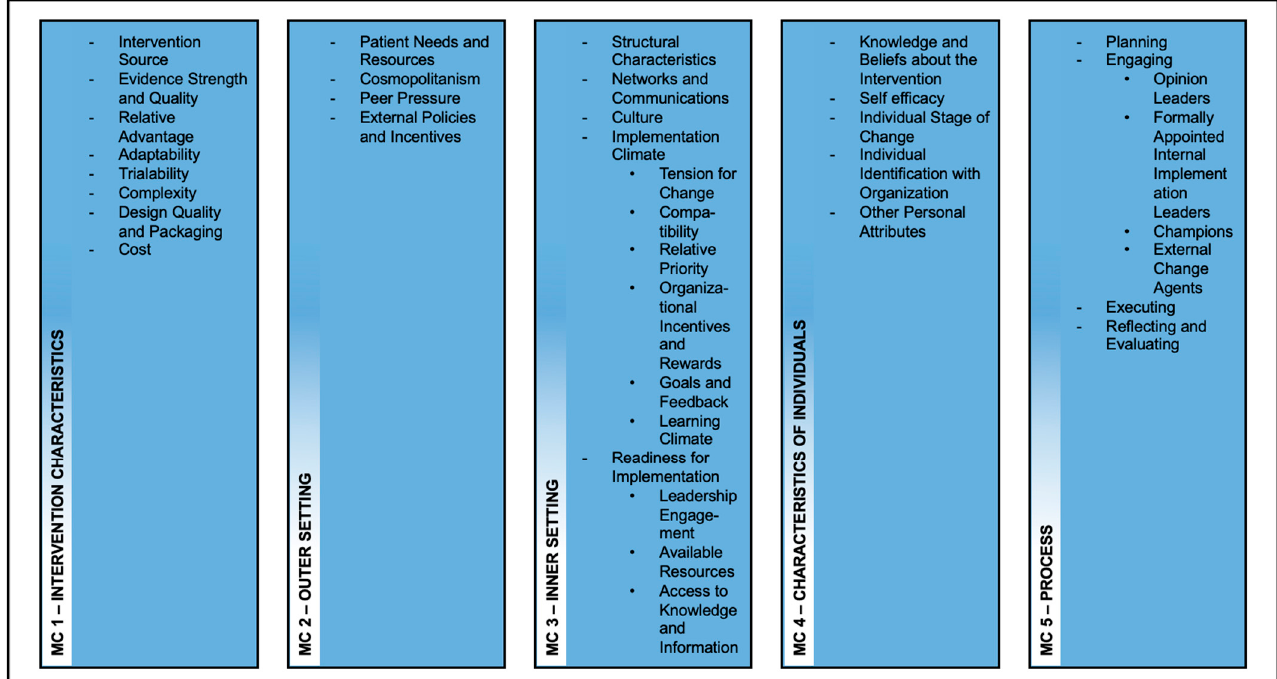
Figure 2. Codesystem from MAXQDA—oriented to CFIR.